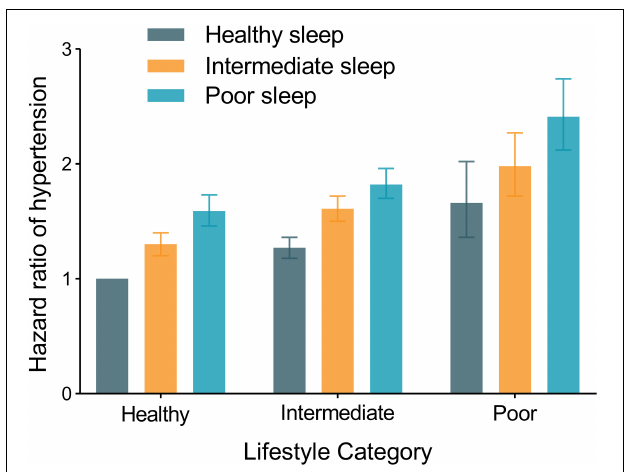
FIGURE 1 | Joint association of sleep patterns and lifestyles with hypertension incidence among 165,493 participants. The models were fully adjusted for age, sex, ethnicity, education, Townsend deprivation index, household income, baseline mean arterial pressure, alcohol consumption, healthy lifestyle categories, family history of hypertension, baseline cardiovascular disease, diabetes, chronic kidney disease, and cancer.